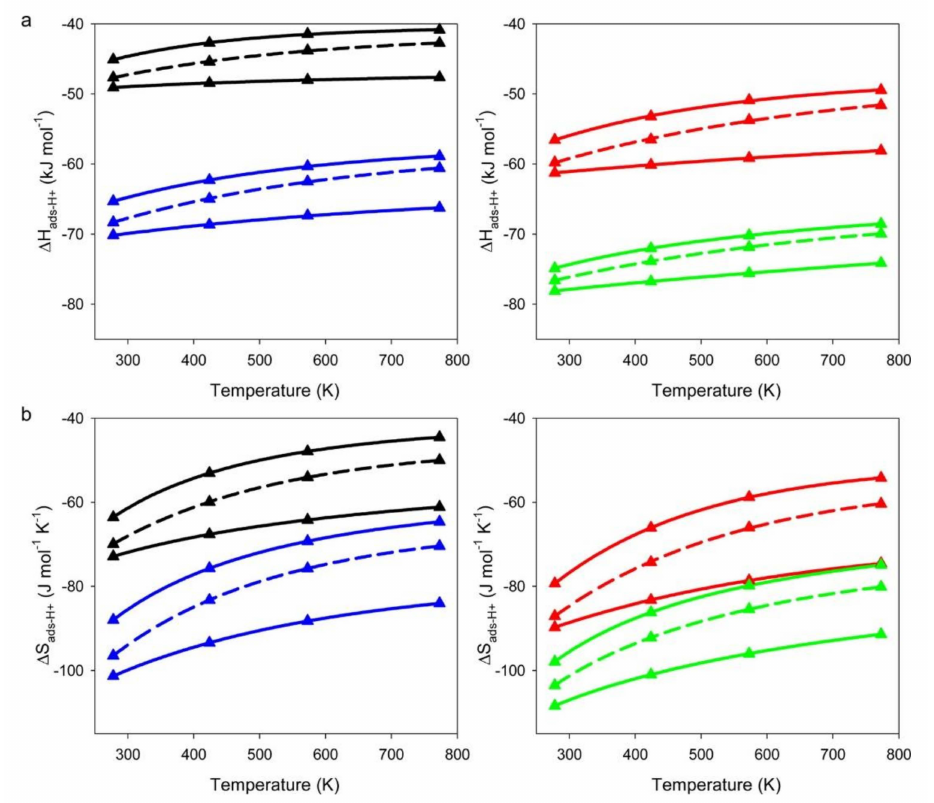
Figure 1. CBMC simulations of ( a ) adsorption enthalpies ( ∆ H ‡ of propane (black triangles), butane (red triangles), pentane (blue triangles), and hexane (green triangles). The upper and lower solid lines represent acid sites located at T9 and T4, respectively. Boltzmann weighted averages of ∆ H ‡ are illustrated as dashed lines. Reprinted with permission from [13]. Copyright 2015, American Chemical